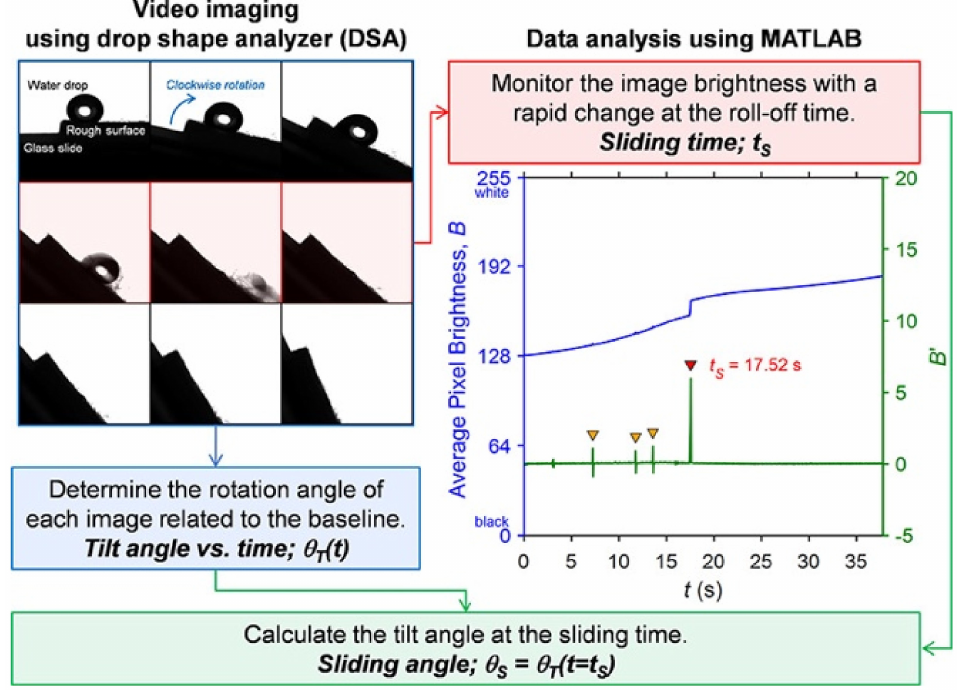
Figure 25. Determination of the SA using an image analyzer aided by a computational algorithm